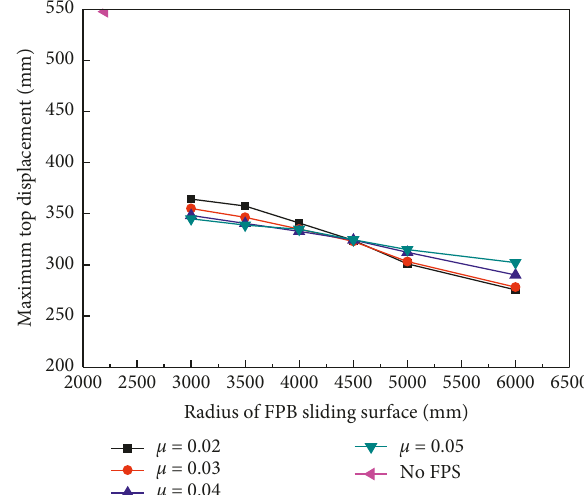
d and μ in the Y